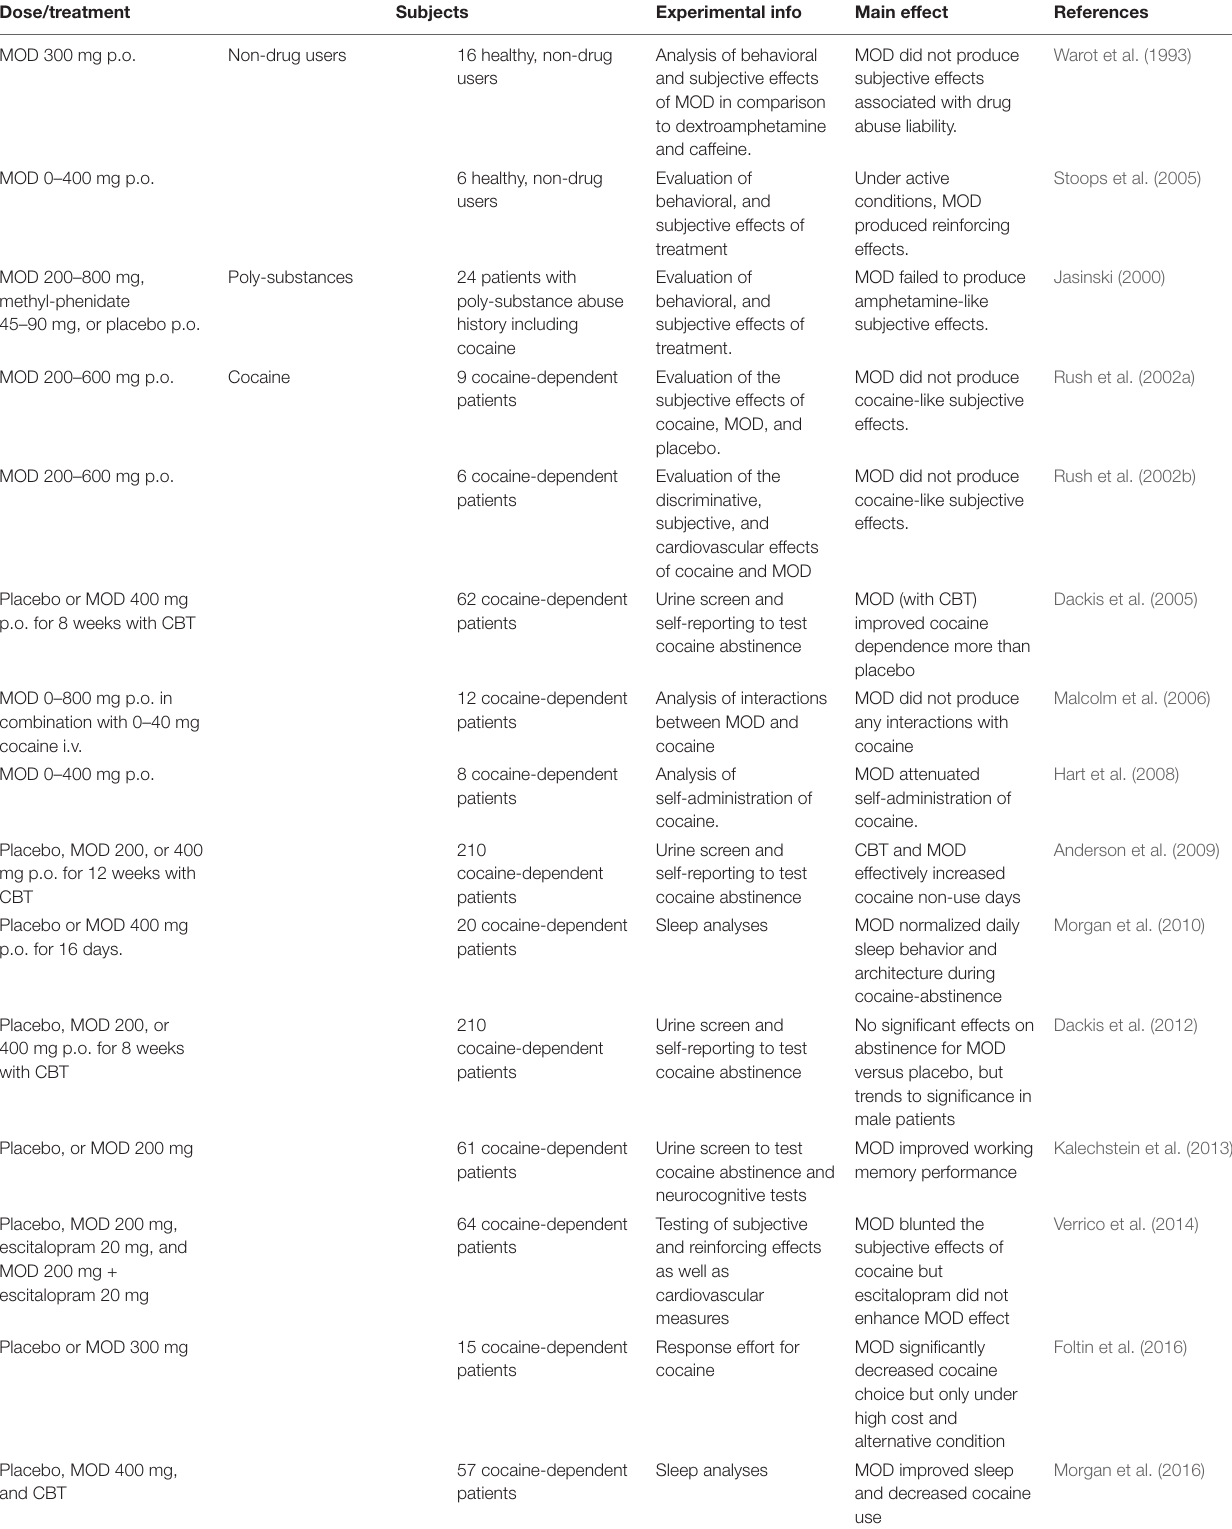
TABLE 4 | Results of clinical studies on MOD as a pharmacological therapy for PSUD, including studies on sleep disorders and cognitive dysfunction in PSUD